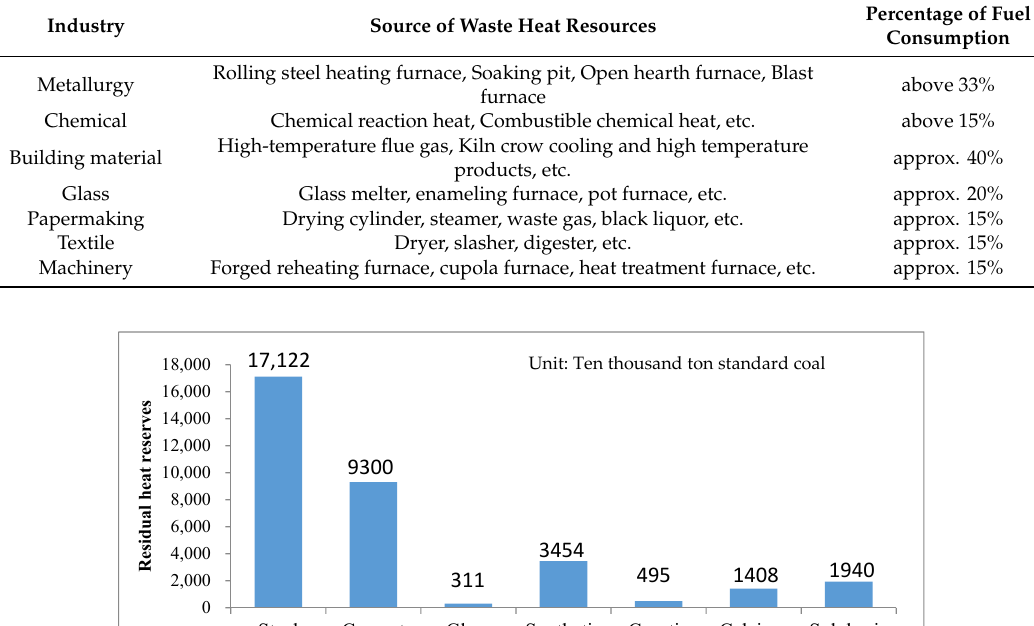
Table 1. Status of industrial waste heat resources based on different industries.